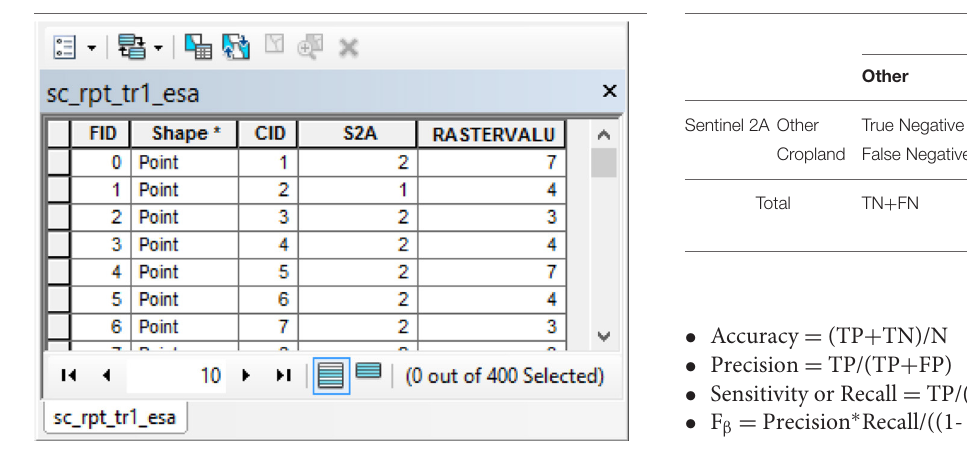
TABLE 3 | Conventional naming of typical binary confusion matrix